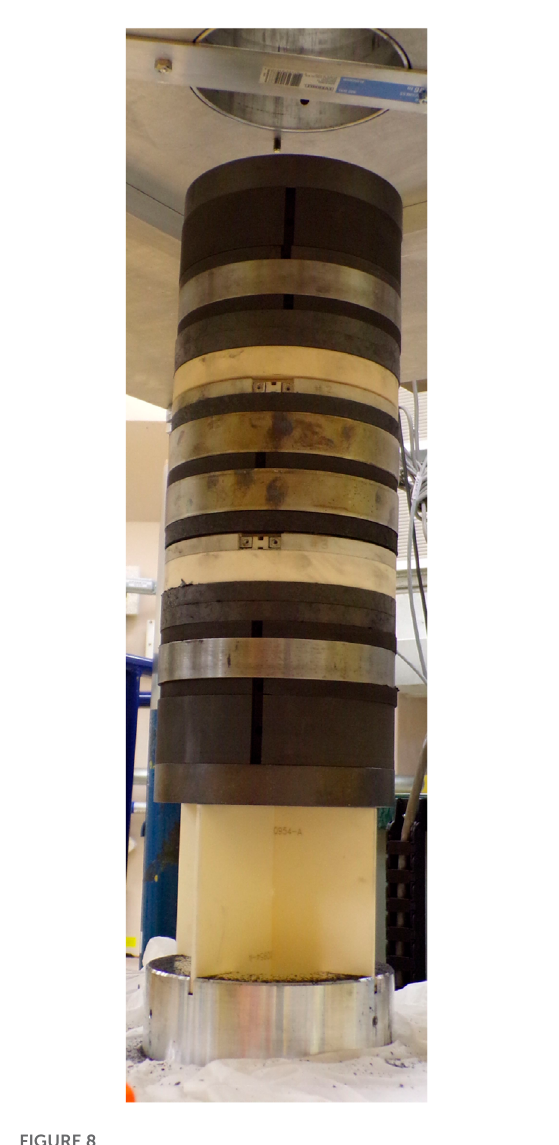
FIGURE 8 Photo of the core stack during the Hypatia